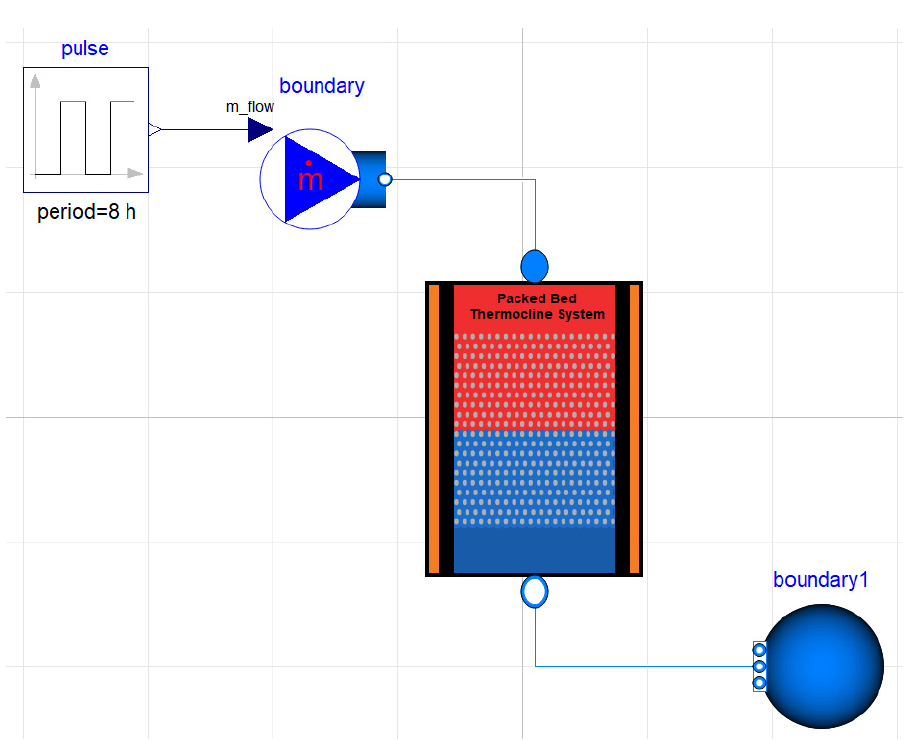
Figure 4. Periodic charging and discharging thermocline test.